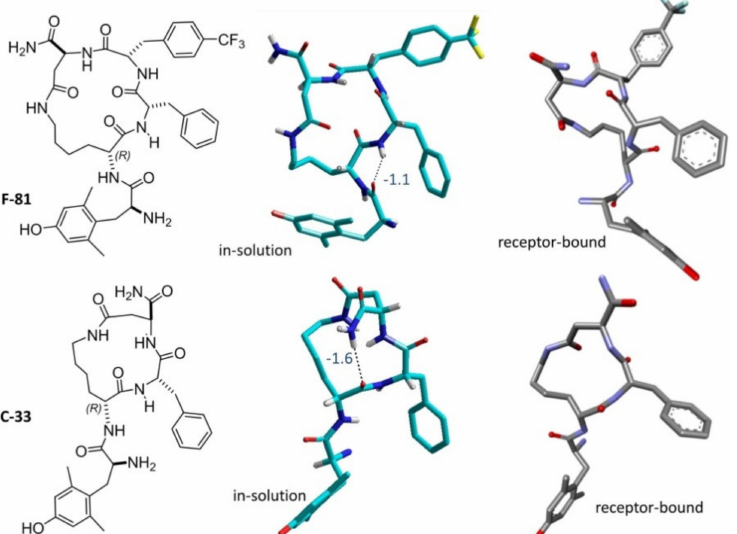
Figure 5. Comparison between the sketches of F-81 and C-33 and the respective in-solution structures (C is rendered in cyan, N in blue, and O in red; hydrogen bonds and the VT NMR ∆ δ / ∆ t values in ppb/K of relevant amide protons are also given) as determined by NMR analysis and molecular dynamics, compatible with VT NMR data, and the calculated receptor-bound structures (C is rendered in grey, N in blue, and O in